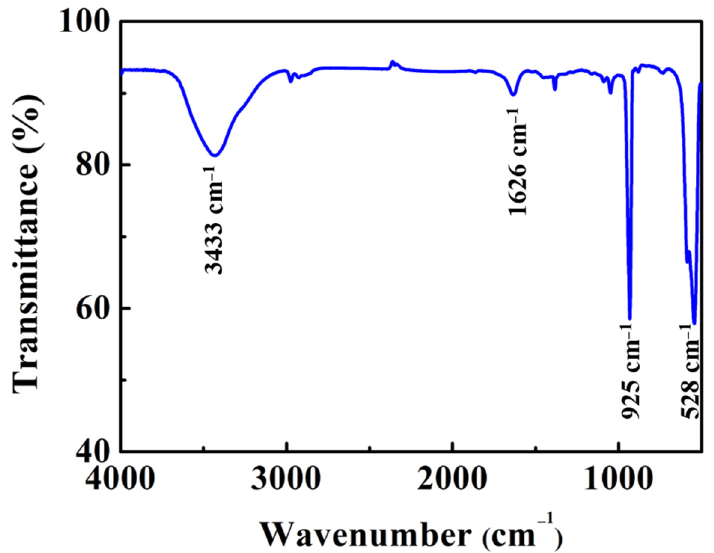
Figure 3. Infrared spectrum of NNOF:Mn 4+ .